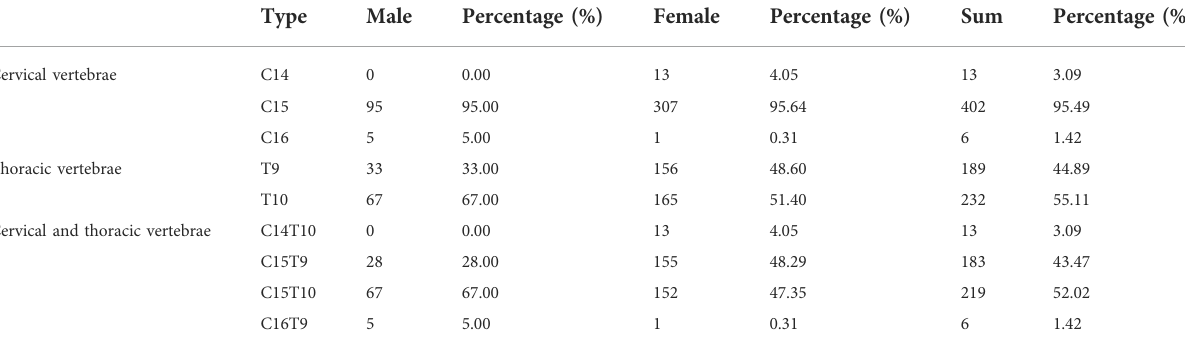
TABLE 1 CVN (number of cervical vertebrae) and TVN (number of thoracic vertebrae) distribution in the Pekin duck × mallard F2 population.